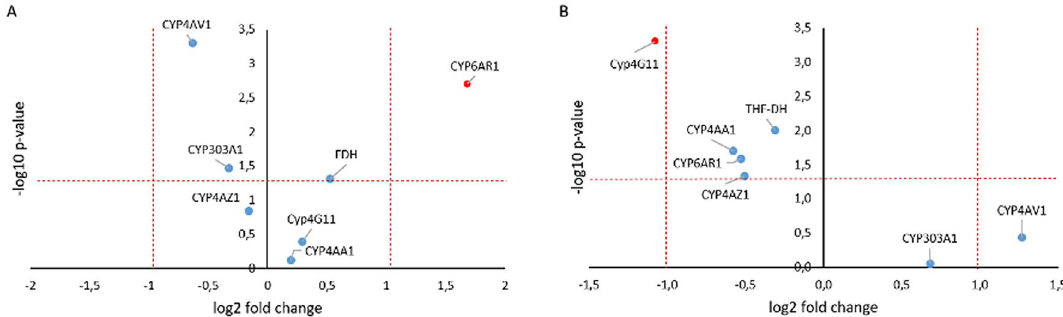
Figure 6. Summary of RT-qPCR data from ( A ) workers and ( B ) larvae of seven differentially expressed transcripts upon FA treatment. A volcano plot analysis of differently expressed genes between the untreated control (0 h) and FA treated group (24 hpt) is plotted on the x-axis (log2 scale), and the statistical significance (p ≤ 0.05) is plotted on the y-axis (− log10 scale). The dotted lines show fold-changes above or below a two-fold up- or down-regulation (values right and left of the vertical lines) and statistical significance (values above the horizontal